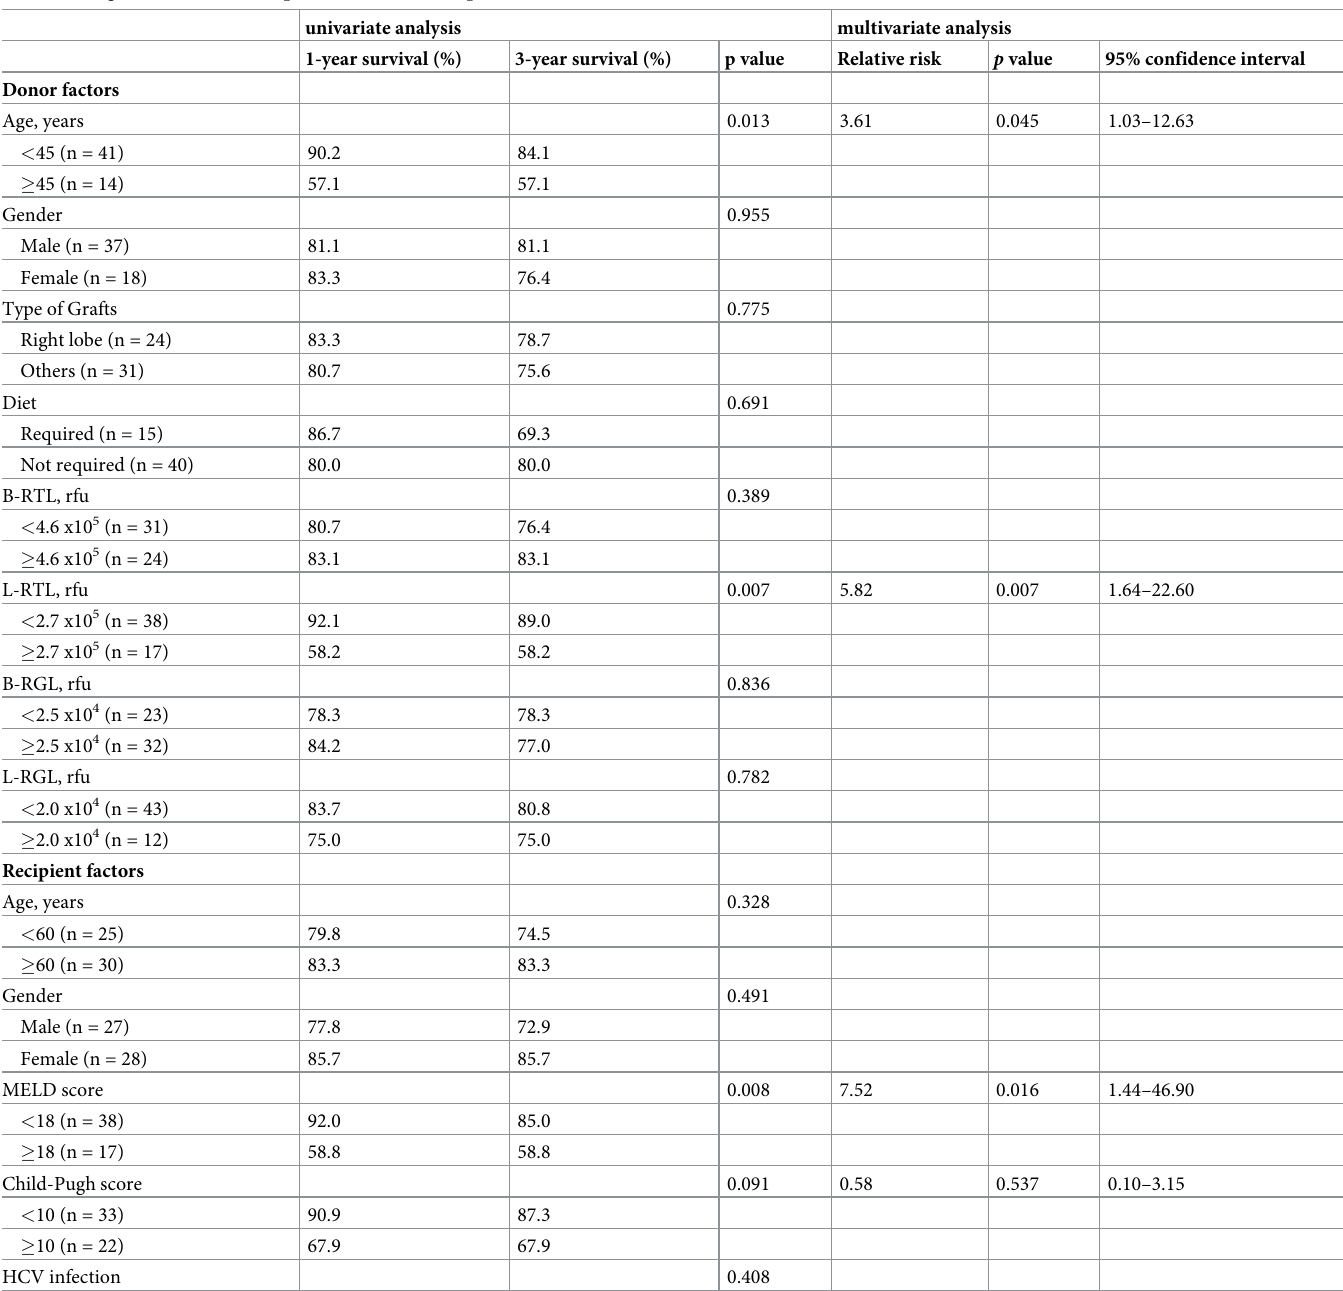
Table 3. Prognostic factors of recipients after liver transplantation. univariate analysis multivariate analysis